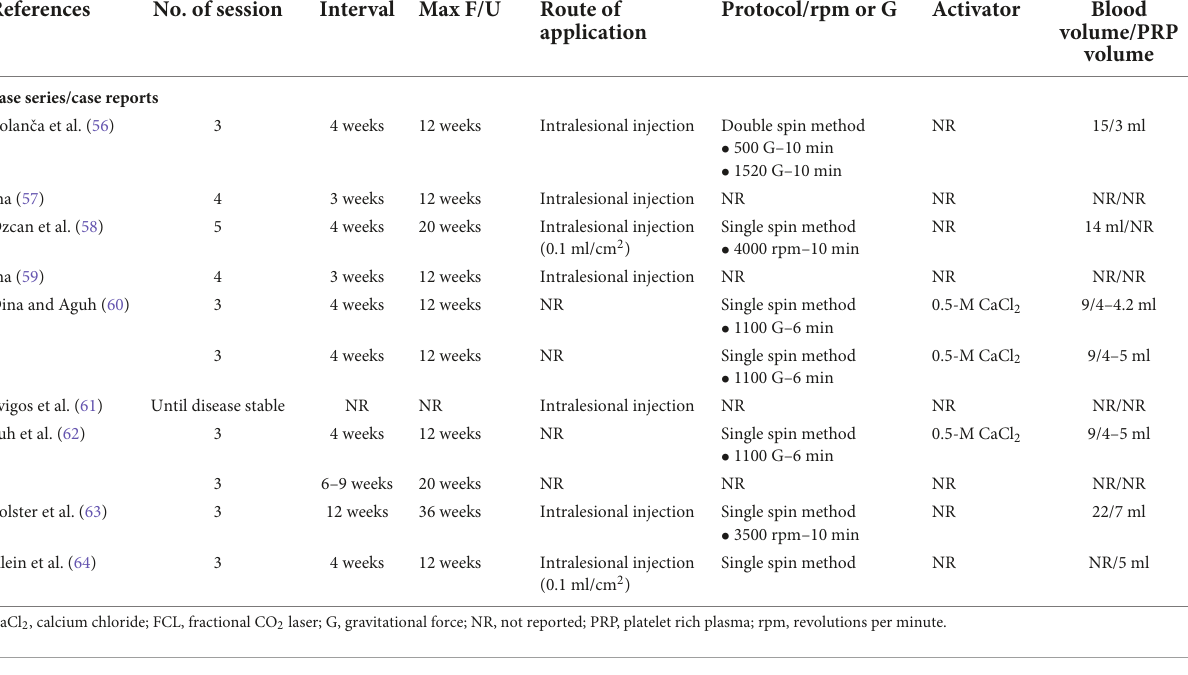
TABLE 4 Platelet-rich plasma preparation protocols of included primary cicatricial alopecia studies.